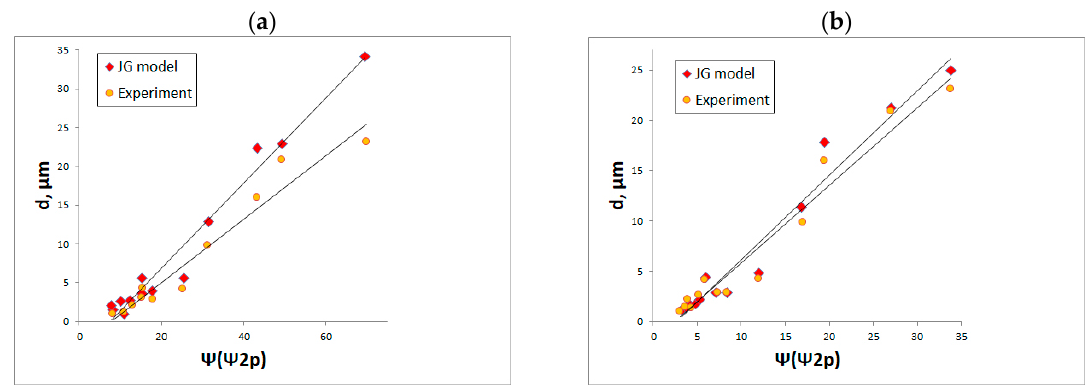
Figure 19. Plastic deformation and elastic-plastic deformation of one-process and two-process steel surfaces, according to the JG model [6], as a function of the plasticity index for sampling intervals of 3 ( a ) and 12 µm ( b ), for the contact load of 950 N, adapted from [174].